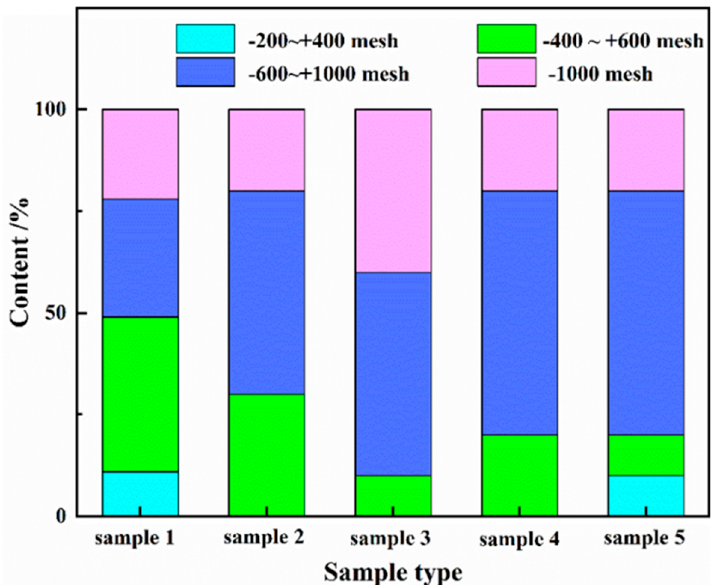
Figure 1. The particle size distribution of five groups of powder samples.